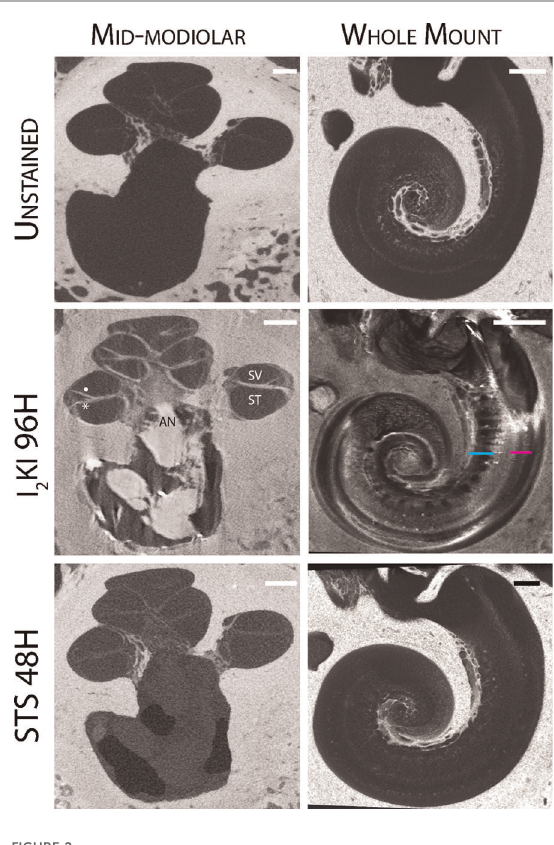
FIGURE 2 Reversible iodine staining of temporal bones. Mid-modiolar 2D virtual cross sections are displayed next to virtual cochlear wholemounts. Staining with I 2 KI greatly enhances the resolution of intracochlear structures. In the mid-modiolar view of I 2 KI stained bone, basilar membrane (*) and Reissner ’ s membrane ( (cid:129) ) are visualized with clear distinctions between scala tympani (ST) and scala vestibuli (SV). In the virtual wholemount, distinct cytoarchitecture of the modiolar core is appreciated, including auditory nerve (AN) fi ber bundles (teal underline), and the organ of Corti containing hair cells (pink underline). These features are no longer visualized following destaining with STS for 48 h. I 2 KI, Lugol ’ s iodine solution; STS, sodium thiosulfate. All scales=1